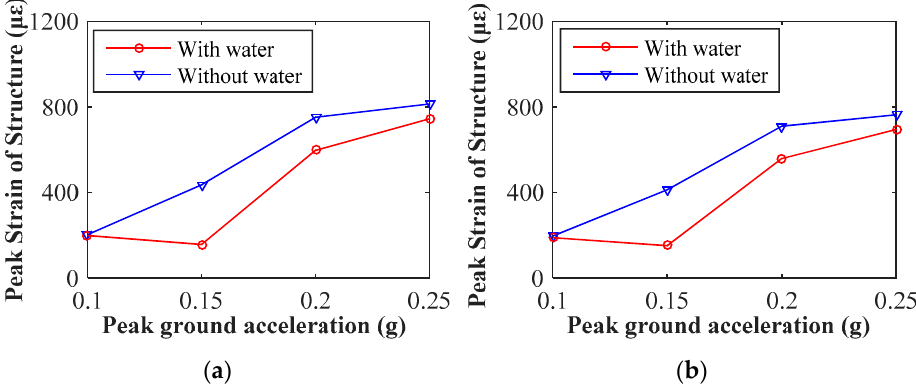
Figure 17. Structural strain response of the electrical platform in the with/without water condition under API seismic wave. ( a ) The strain response of S1 and ( b ) the strain response of S2.